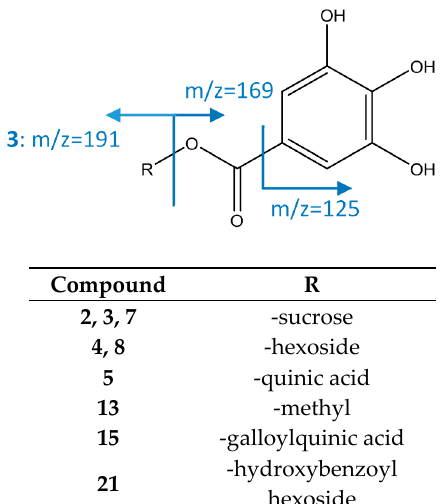
Figure 7. Structure and fragments of gallate derivatives.